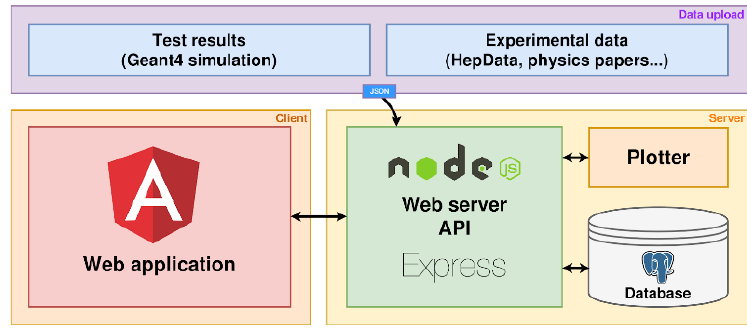
Figure 1. Components of Geant-val web application and flow of data between